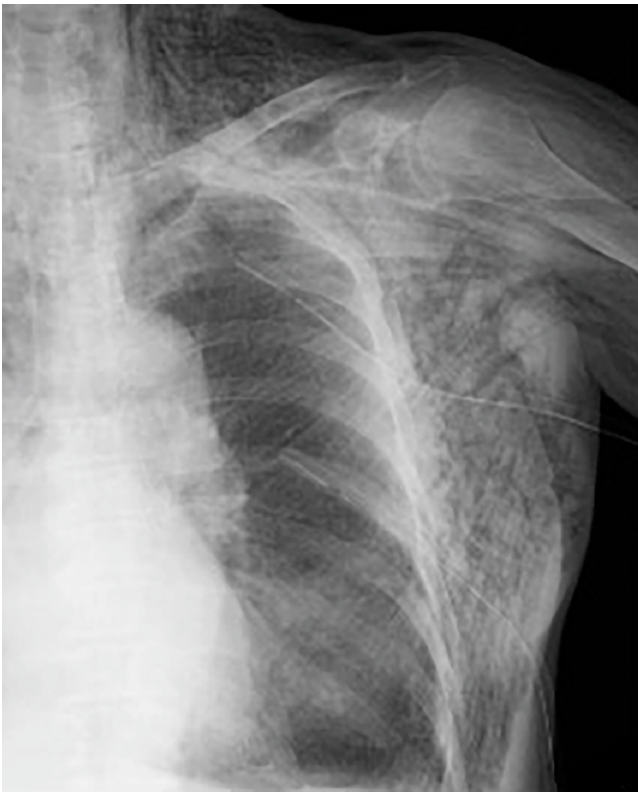
Figure 4. An additional drain (20 Fr) was placed from the left anterior chest to the left thoracic cavity. We were able to confirm that the thoracic drain position was not a problem, and neither mediastinal nor subcutaneous emphysema worsened thereafter (Figure 5a,b).